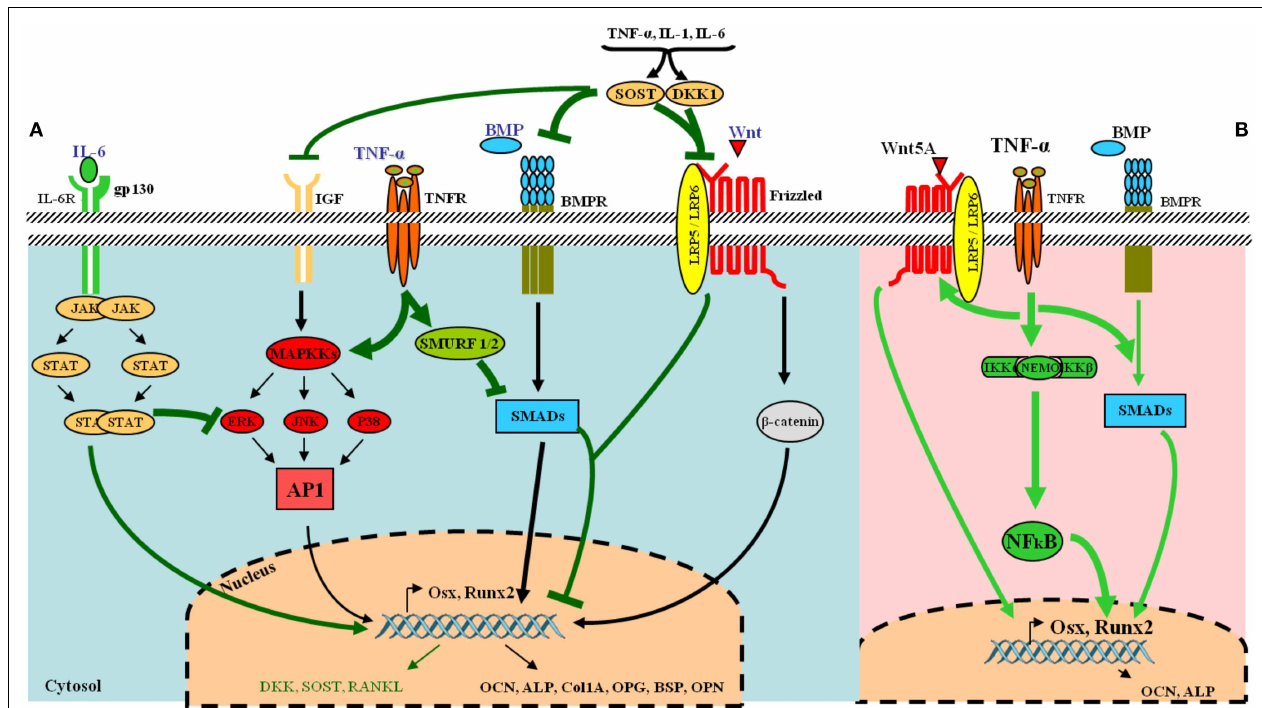
FIGURE 2 |Tumor necrosis factor- α and its osteoblastogenesis paradoxical effects . (A) Under normal condition, various receptors and downstream signaling pathways can be activated in osteoblasts.The most common ligands, receptors, and their signal transduction are represented in black. Essential pathways involve bone morphogenetic proteins (BMPs) and their receptors, acting via SMAD proteins to directly or transcriptionally activate RUNX2 and its subsequent downstream cellular events and theWnt–frizzled pathway, which utilizes β -catenin for further activities. Under inflammatory conditions, the release of pro-inflammatory cytokines such asTNF- α and IL-6 leads to the inhibition of osteogenic differentiation via several mechanisms (represented in green in the figure). IL-6 inhibits mitogen-activated protein kinase (MAPK) activities by activated signal transducers and activators of transcription (STAT).TNF- α